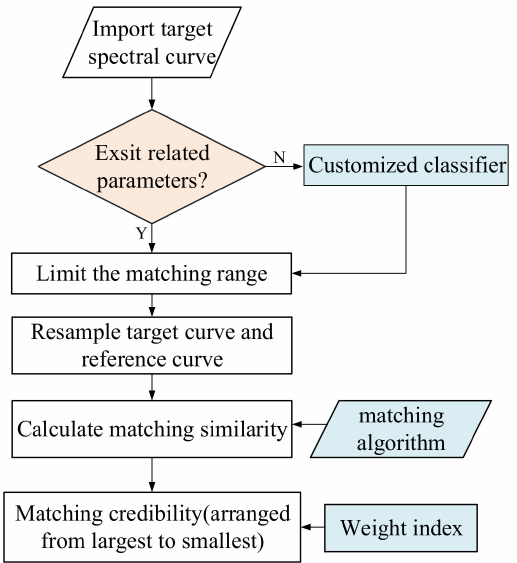
Figure 6. Operating mechanism of spectral